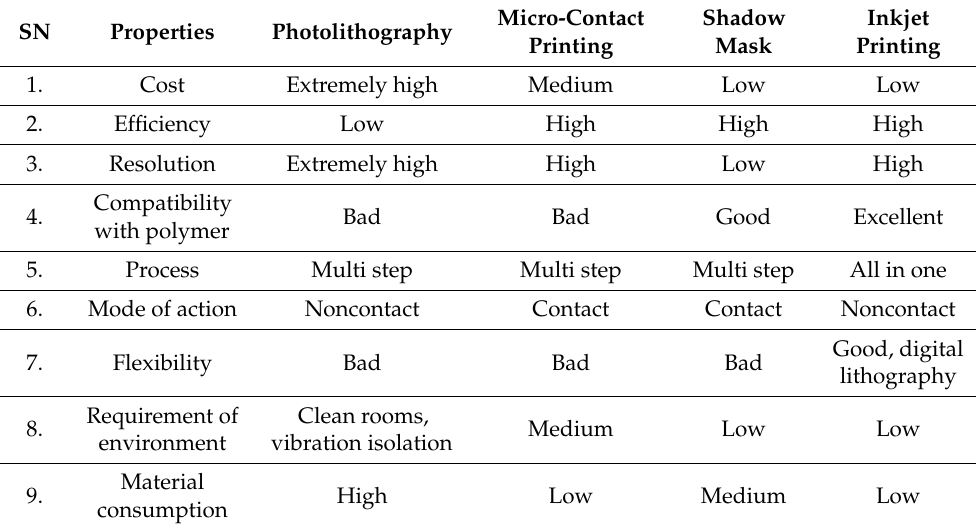
Table 1. Comparison of some typical patterning technologies [50].